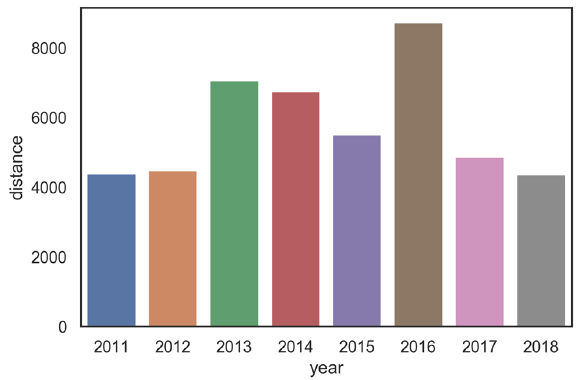
Figure 10. 99th percentile in meters of distance from highway to crime by year.